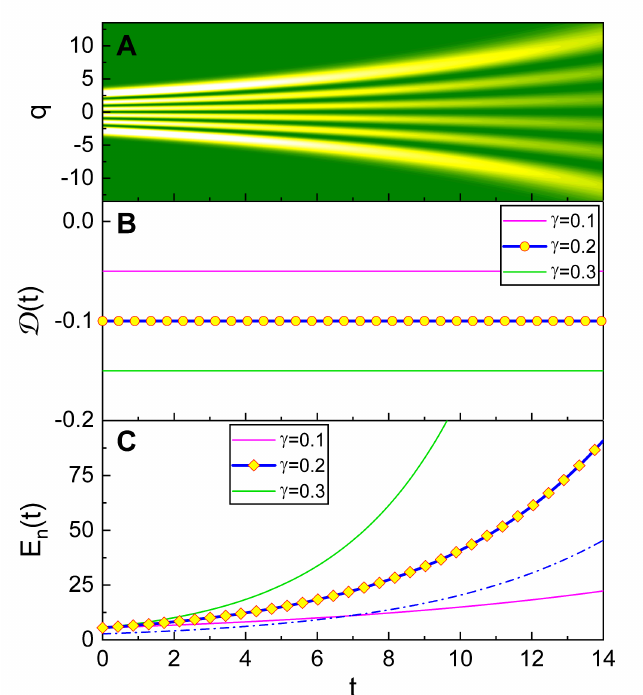
Figure 3. Contour plot of the probability density |(cid:104) q | ψ n (cid:105) A | 2 ( A ) as a function of q and t for the quantum wave given in Equation (28), where we have chosen γ = 0.2; the corresponding temporal evolutions of the ratio D ( t ) ( B ) and the quantum energy E n ( t ) ( C ) for several different values of γ . The extra line (the dash-dot line) in C is quantum electric energy T n ( t ) ( = V n ( t ) ) for the case of γ = 0.2. We have used n = 5, ω 0 = 1, ¯ h = 1, and (cid:101) = 1. This figure shows amplification of the quantum light